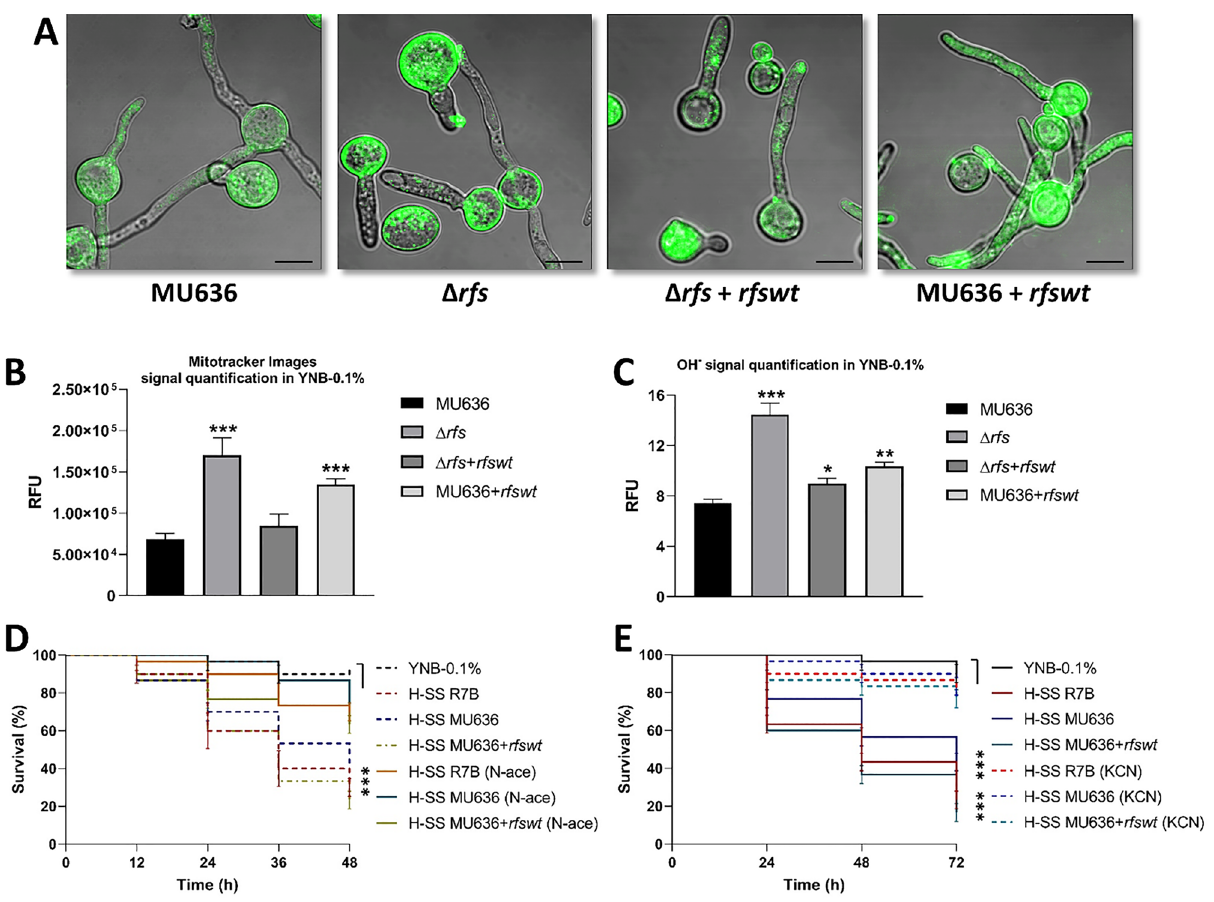
Figure 7. Role of Rfs in the mitochondrial membrane potential, reactive oxygen species generation, and M. lusitanicus virulence. Germinules formed at 3 h of growth in YNB with 0.1% glucose (YNB-0.1%) were visualized ( A ) in the presence of MitoTracker Green FM, following which the cells were visualized by confocal microscopy (120 ×), bars = 20 mm. The fluorescence signal was quantified using the ( B ) Mitotracker signal and ( C ) hydroxyl radical (OH − ) concentration. The results presented are the average of values obtained from four independent experiments. Significance testing was performed using ANOVA with Fisher’s exact test, * P < 0.05; ** P < 0.01; *** P < 0.001. ( D ) Effect of 10 mM N- acetylcysteine (N-ace) or ( E ) 0.5 mM potassium cyanide (KCN) on the virulence of cell-free supernatants of the culture (SS) from MU636-, R7B-, and rfs -overexpression (MU636 + rfswt ) strains aerobically grown (H-SS) in YNB-0.1%. The SSs were used to treat Caenorhabditis elegans . A total of 15–20 nematodes were used per experiment and incubated at 18 °C for 72 h. The results presented are the average of values obtained from four independent experiments. Data were statistically analyzed using the Mantel-Cox test. *** P < 0.01. When results were not considered significant, we did not provide an additional indication ( P >